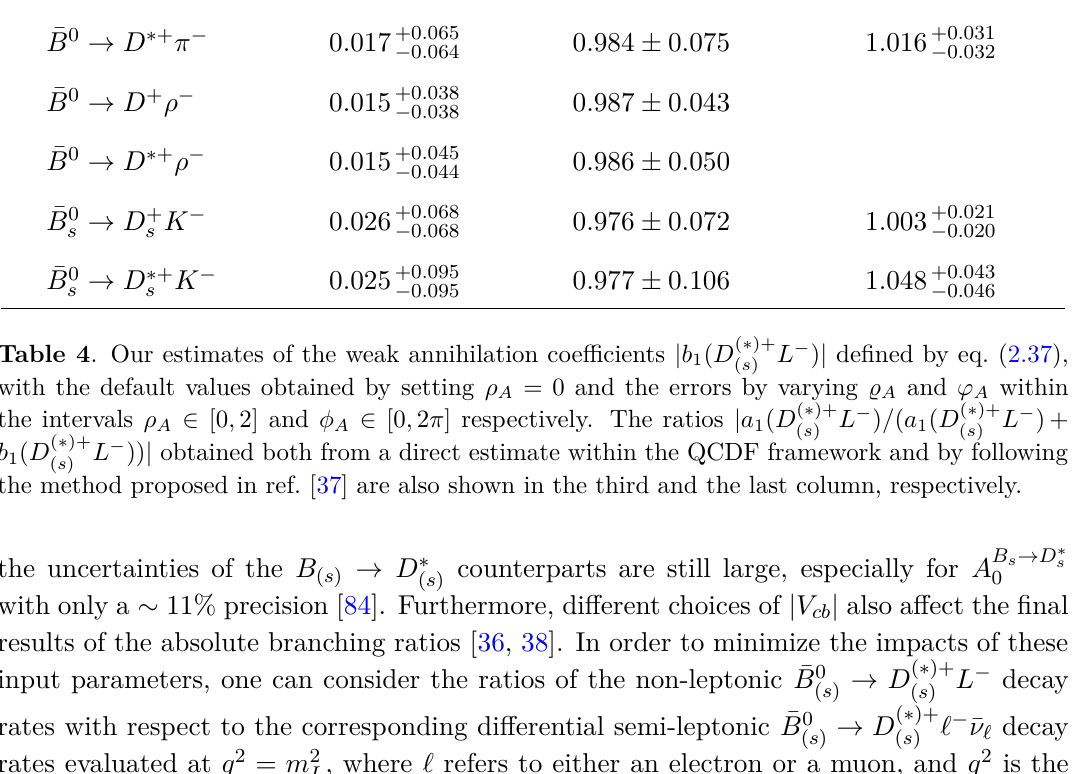
L − ) | defined by eq. (2.37), ( s ) L − ) / ( a 1 ( D ( ∗ )+ L − ) + ( s ) ( s )